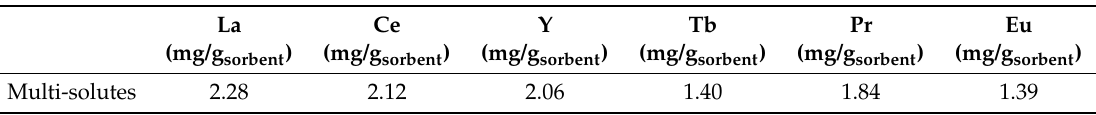
Table 5. Uptake values for the multi-component solution in contact with biofilm supported on zeolite, in mg/g sorbent . La Ce Y Tb Pr Eu (mg/g sorbent ) (mg/g sorbent ) (mg/g sorbent ) (mg/g sorbent ) (mg/g sorbent ) (mg/g sorbent ) Multi-solutes 2.28